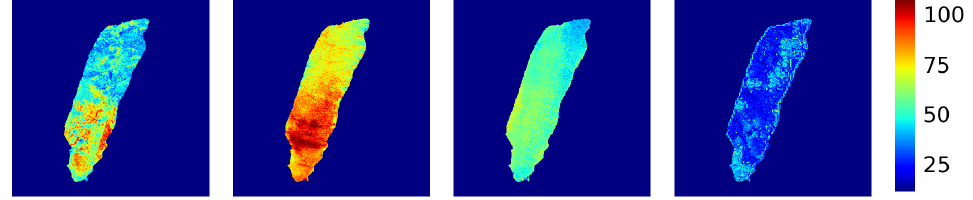
Figure 4. Chl-a estimation maps ( µ g/L) for spring, summer, fall, and winter 2017, respectively. They were generated using the proposed multitask